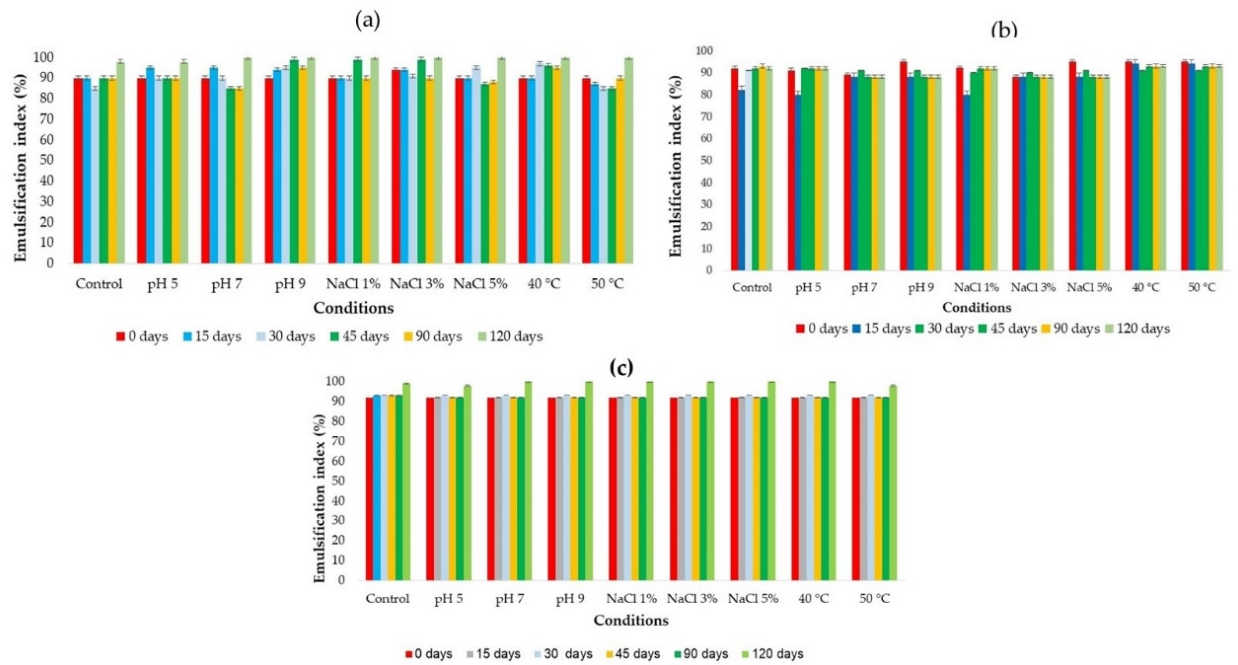
Figure 7. Emulsification index of the biosurfactant produced by Candida sphaerica submitted to different preservation treatments, ( a ) 0.2% potassium sorbate, ( b ) fluent steam + 0.2% potassium sorbate, ( c ) fractionated tyndallization, and stored under different conditions over a period of 120 days.